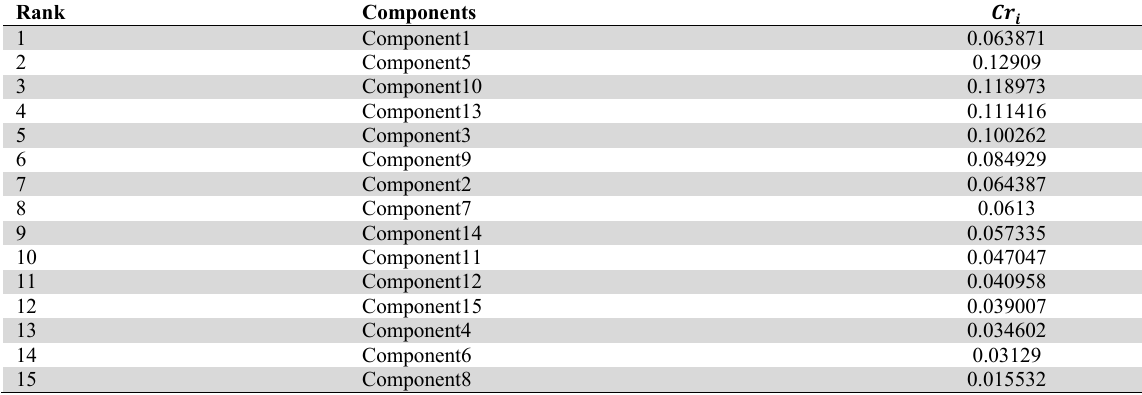
Ranking of the components according to the criticality